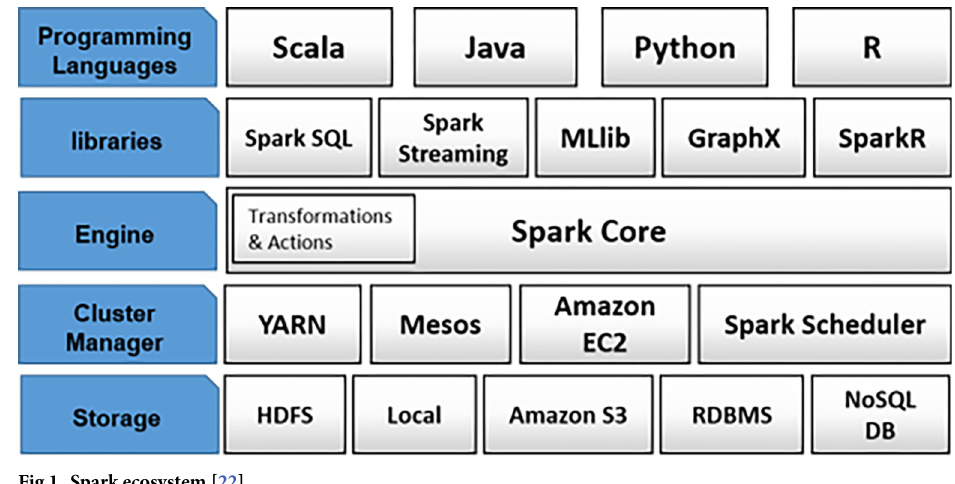
Fig 1. Spark ecosystem [22].